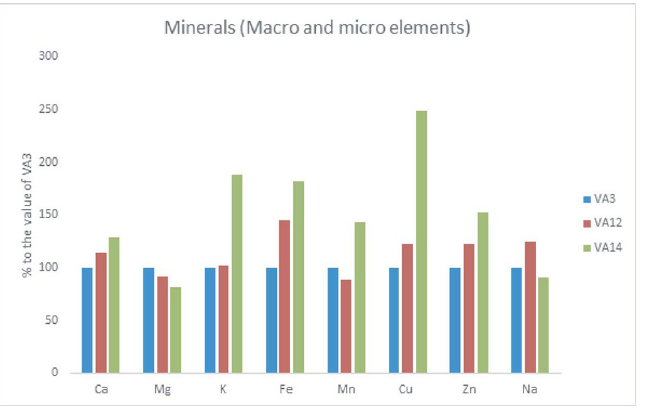
Fig 3. Minerals (macro mg g -1 and micro μ g g -1 nutrient elements) contents (% to the value of VA3) in the leaves of three selected A . tricolor